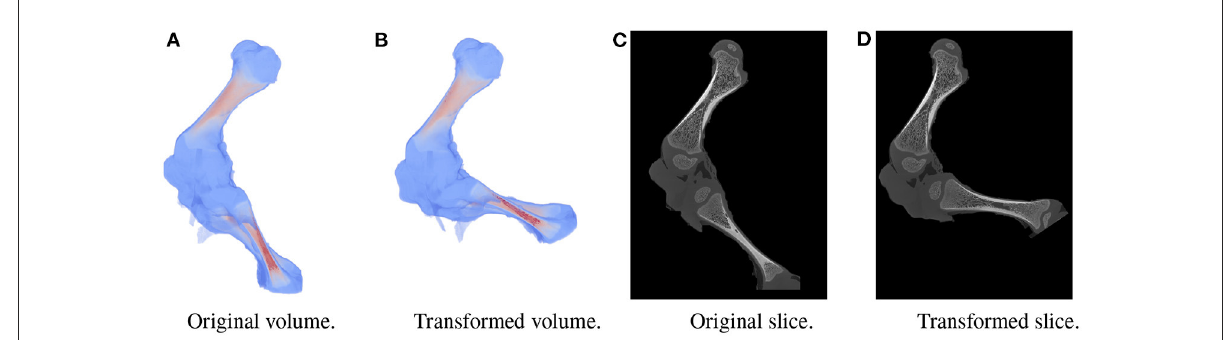
FIGURE6 Original volume (A) and a the polyaffine transformation fusion (B) for rotations of the femur and tibia around their principal transverse axes, with two slices from the original (C) and polyaffine (D) transformed volume. The two slices do not correspond as the transverse axes are not parallel to the volume coordinate axis.